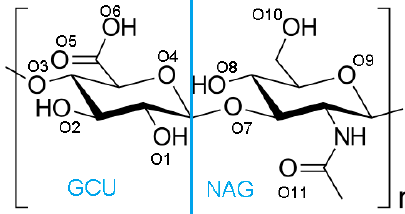
Figure 2. Structure of hyaluronan as composed of two parts GCU ( D -glucuronic acid) and NAG ( N -acetyl- D -glucosamine). Oxygen atoms are numbered to show H-bond formation between specific atoms.